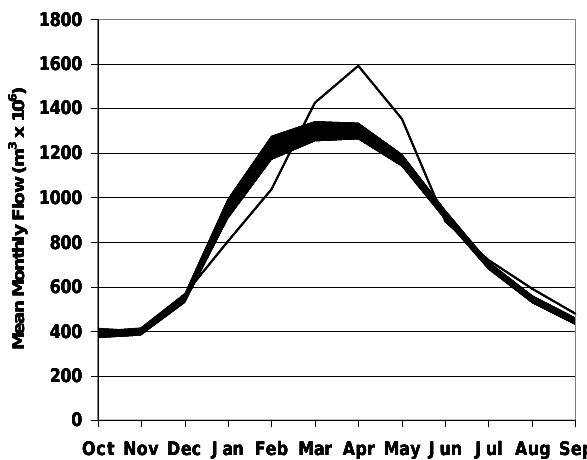
Fig. 7. Seasonal distributions of mean monthly observed flow (thin Figure 7 Seasonal distributions of mean monthly observed flow (thin line) and 845 line) and the envelope of the 1000 member ensemble of simulated the envelope of the 1000 member ensemble of simulated flow for the 846 flow for the Okavango River at Mukwe for the baseline Okavango River at Mukwe for the baseline period. 847